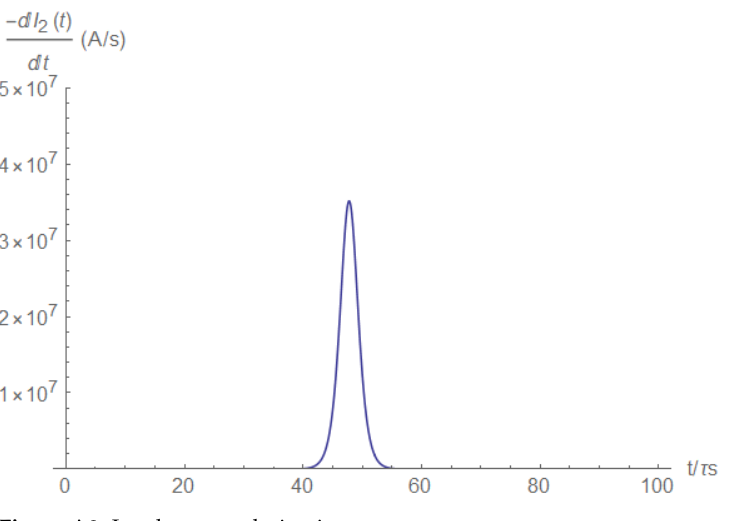
Figure A9. Load current derivative.